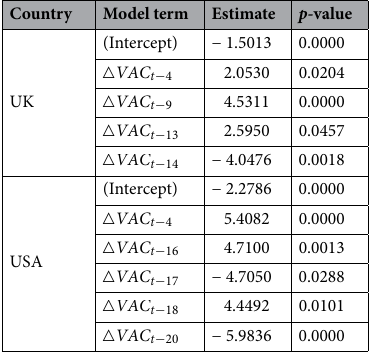
Table 1. Distributed lag model for hospitalization ( △ HOSP ) in UK and USA. Here, the intercept term refers to α in Eq.